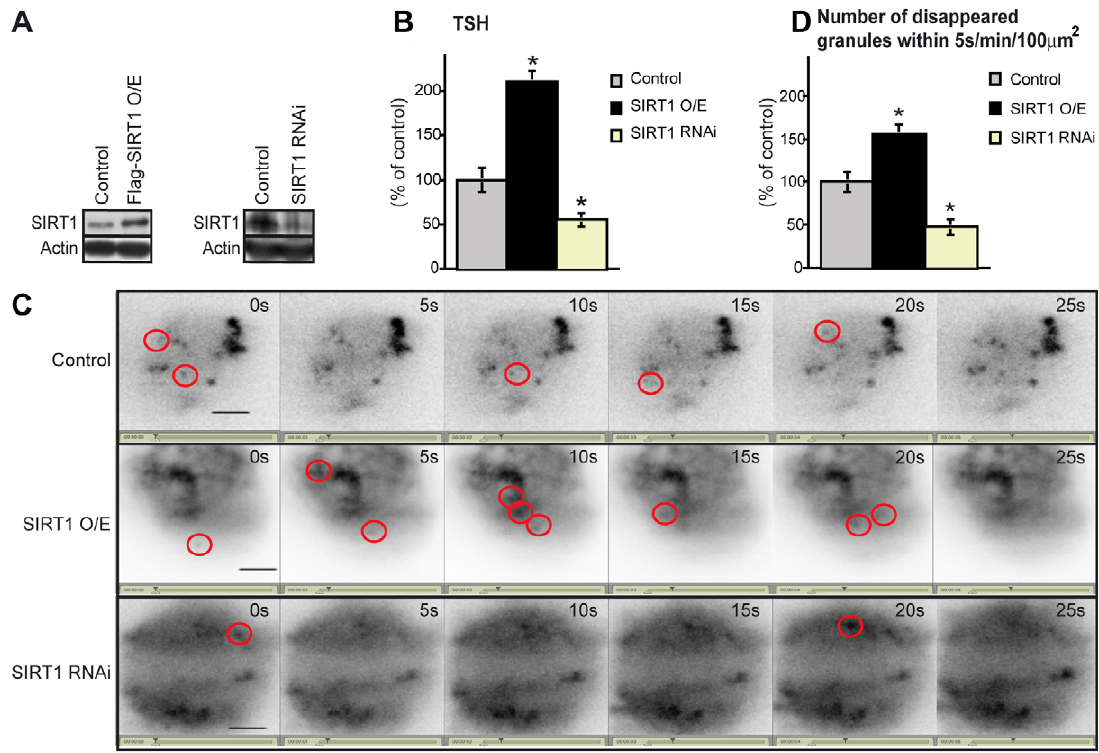
Figure 2. SIRT1 upregulates exocytosis of TSH. (A) Western blot analysis of SIRT1 in primary pituitary cells and in cells overexpressing (O/E) SIRT1 (left panel) and SIRT1 RNAi cells (right panel) levels. (B) Amounts of TSH secreted by SIRT1-O/E and SIRT1-RNAi pituitary cells over 24h ( n =10). Statistical analyses were performed using Fisher’s PLSD test. * P , 0.05 versus control. (C) A TIRF image of an anterior pituitary cell. Several GFP-TSH granules that disappeared within 5 s are circled in red. Scale bar, 20 m m. (D) Number of expelled TSH granules were morphologically identified using the TIRF images ( n =5). Statistical analyses were performed using Fisher’s PLSD test. * P , 0.05 versus control. Values represent mean 6 SEM (% of control: B and